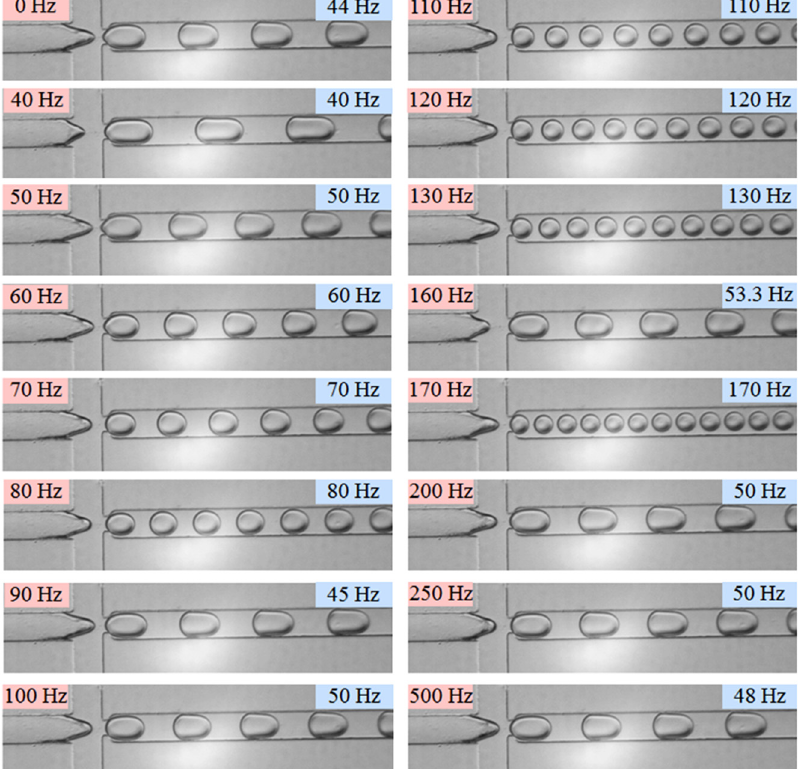
Figure 3. Droplet generation snapshots at different external vibration frequencies. ( Q c = 90 μ L/h, Q d = 60 μ L/h, a m = 60 m/s 2 ; f P are marked on the upper left corner; f G are marked on the upper right corner.).